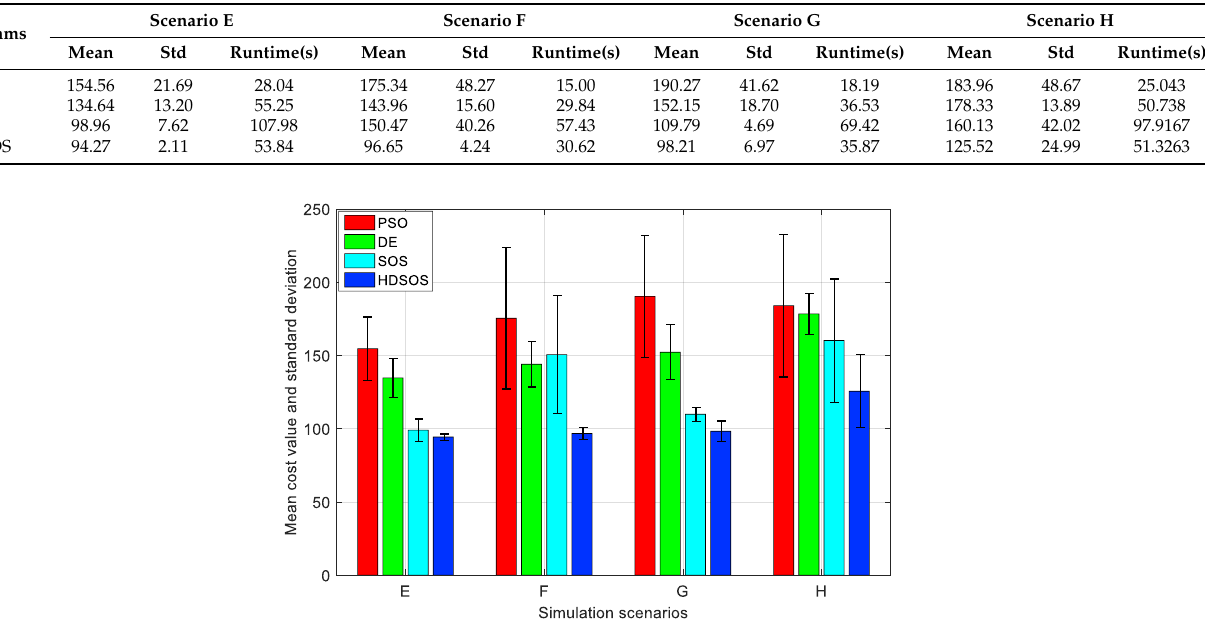
Table 2. Performance of algorithms in three-dimensional scenarios (30 runs).